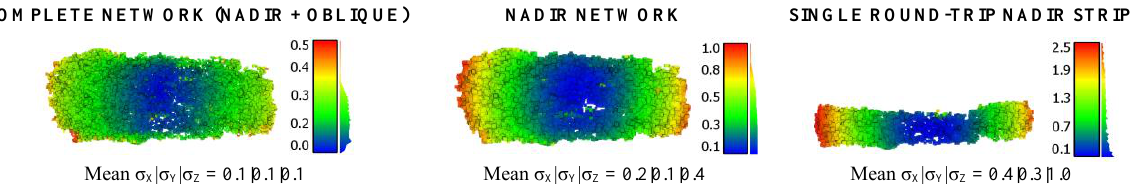
Figure 3. Average Z precision (1 sigma) for the tie points after bundle adjustment with self-calibration (random noise 0.25 px, no distortion camera) in mm.